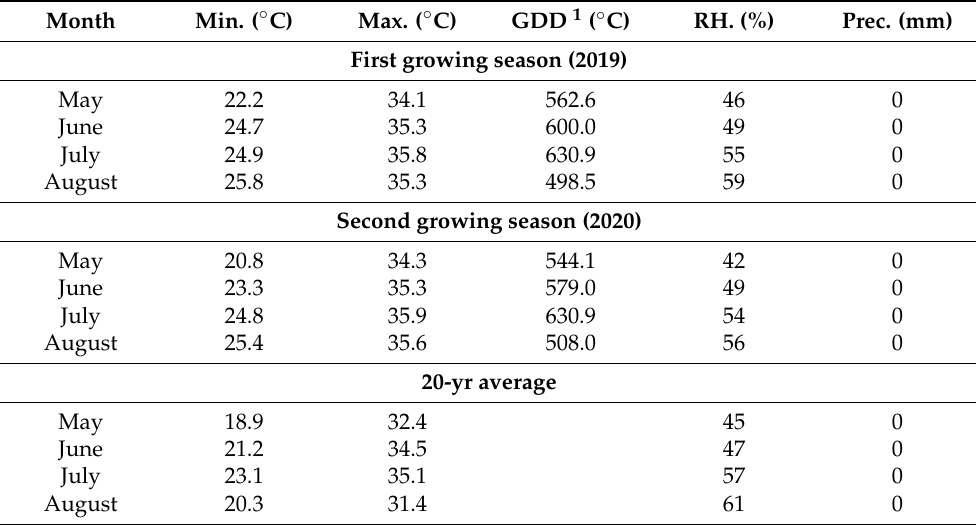
Table 1. Monthly average minimum temperature (Min.), maximum temperature (Max.), cumulative growing degree day (GDD), relative humidity (RH) and total precipitation (Prec.) in 2019 and 2020 growing seasons as well as 20-yr monthly averages (2001–2020).